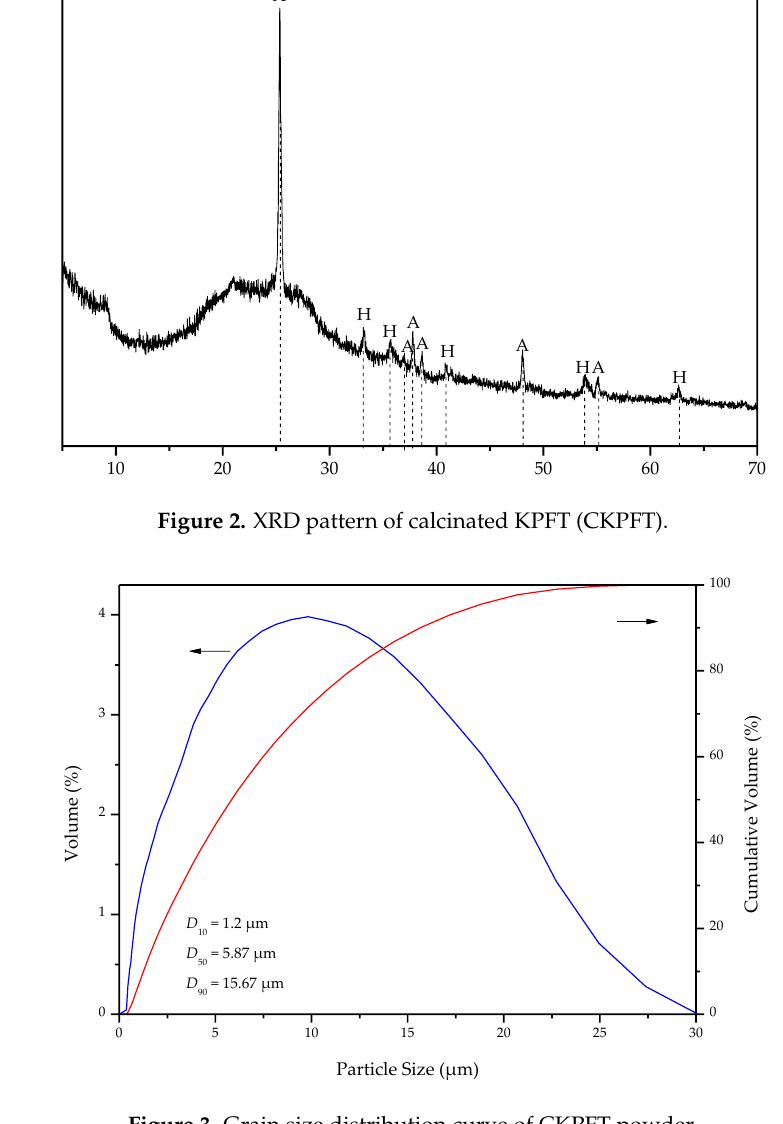
Figure 3. grain size distribution curve of CKPFT powder.